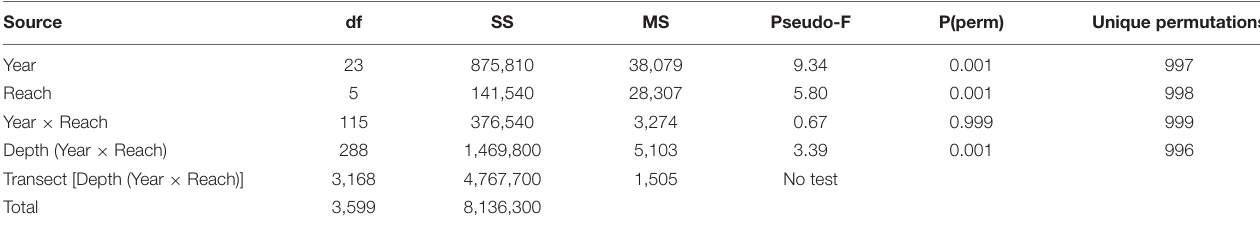
FIGURE 9 | Hierarchical cluster of water depths based on mean percent cover at different depths along transects surveyed from 1996 to 2019. Horizontal line separates groups at a similarity of 0.43. Vertical lines separate depth zones. TABLE 3 | PERMANOVA based on percent cover in each of 6 reaches for the summers of 24